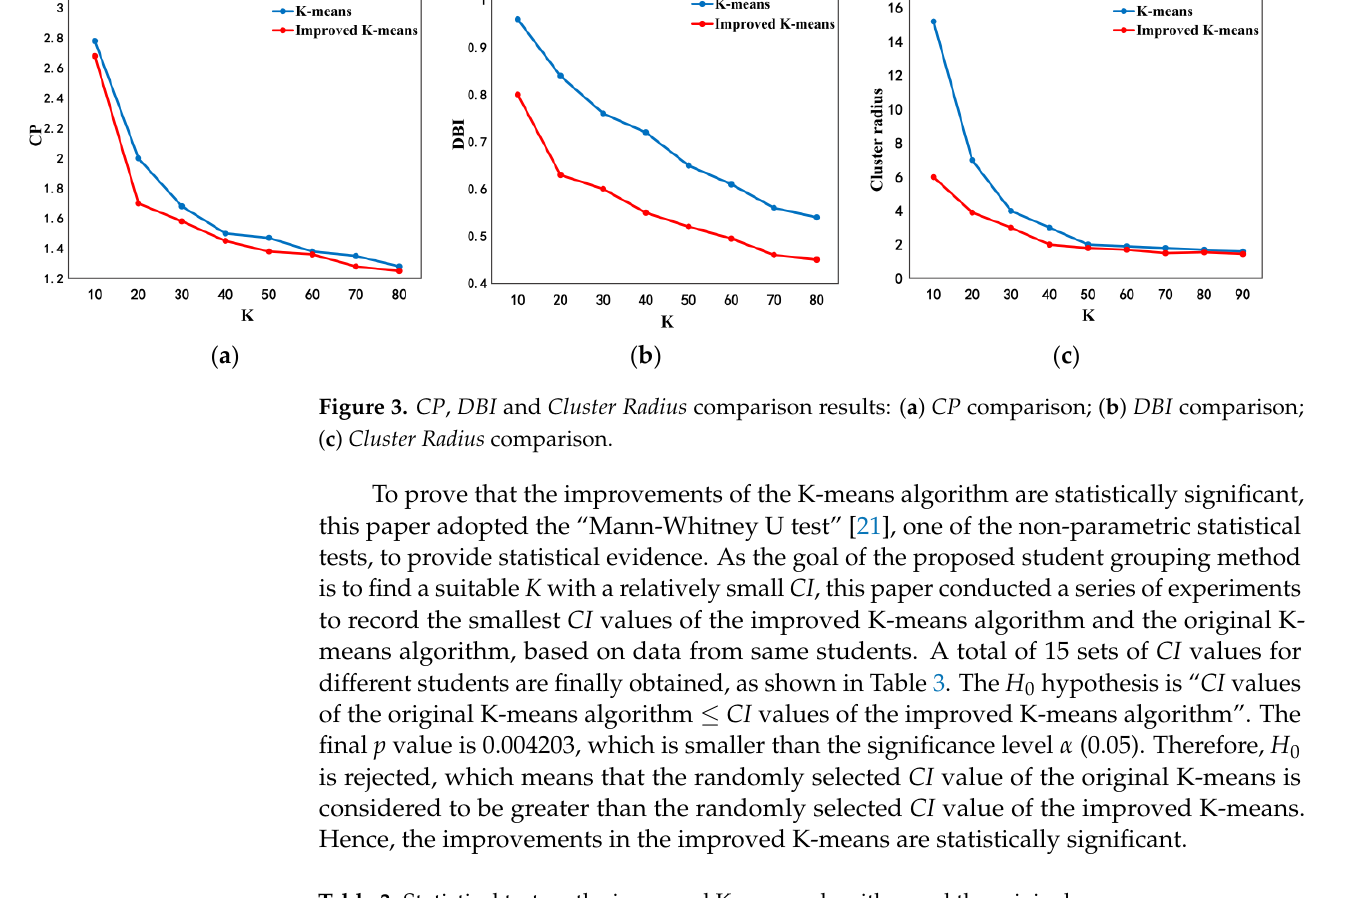
( b ) Figure 2. Comparison of different feature extraction algorithms: ( a ) Accuracy comparison; ( b ) Recall comparison. 5.3.2. Verification of the Student Grouping Method